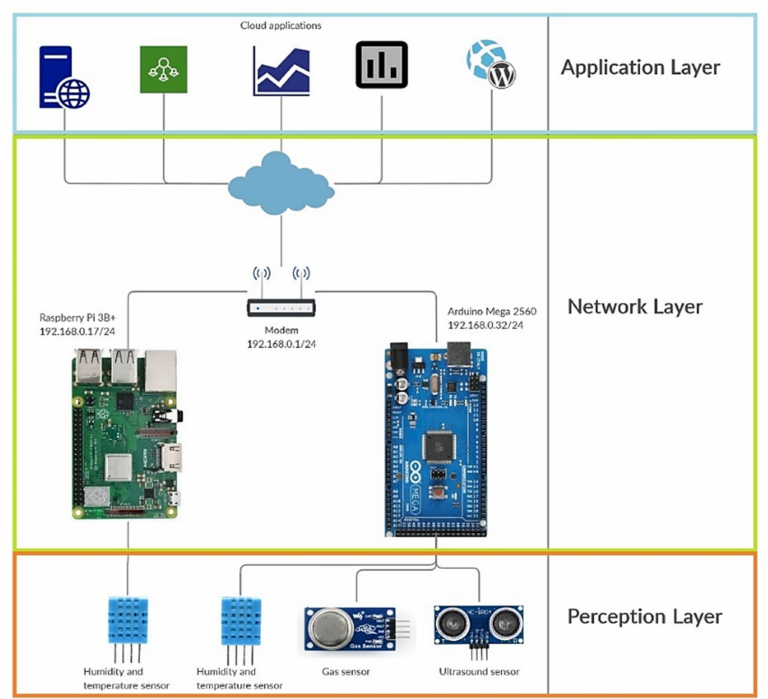
Figure 10. IoT architecture